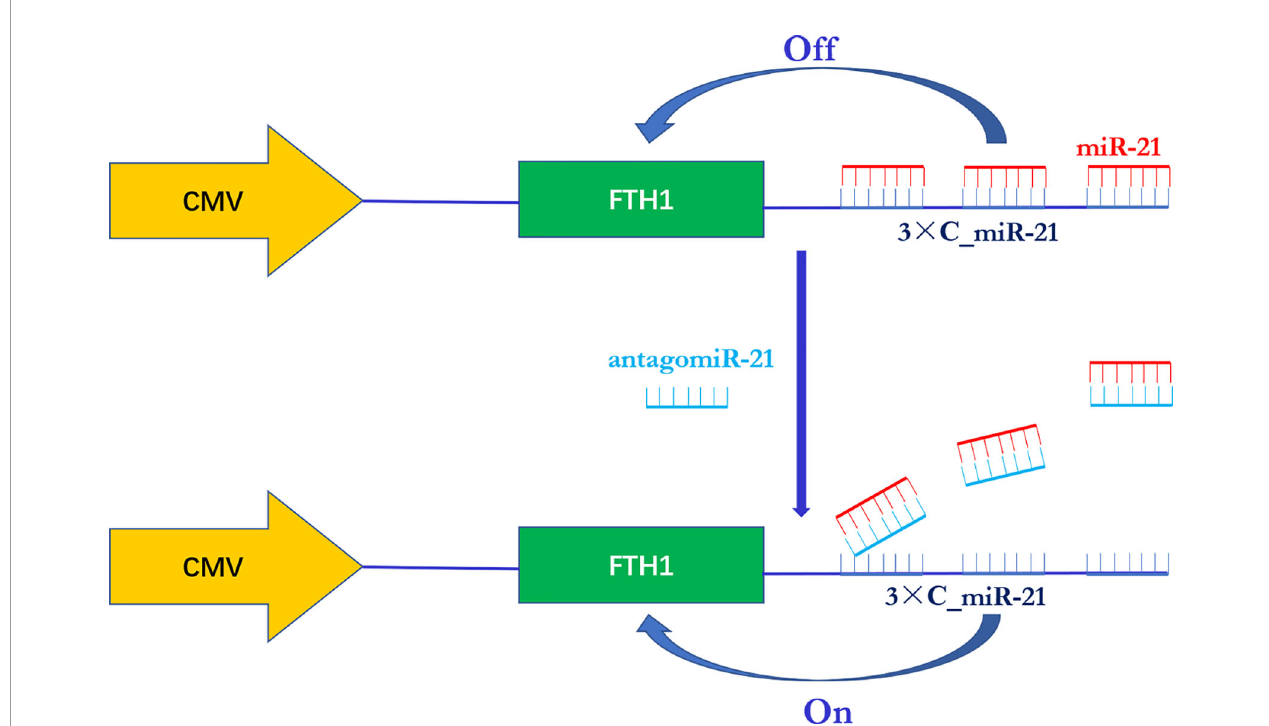
FIGURE 1 | Schematic illustration of the miR-21-responsive FTH1 gene reporter system. The reporter gene FTH1 is modi fi ed by the addition of 3 copies of the sequence completely complementary to miR-21 (3xC_miR-21) to its 3 ’ -untranslated region (3 ’ UTR). In the presence of miR-21, FTH1 expression is switched “ off ” due to the combination of miR-21 with the 3 ’ UTR of the reporter gene. Once an exogenous antisense oligonucleotide (antagomiR-21) is administered, it binds to miR-21 in a competitive manner and releases miR-21 from the 3 ’ UTR of FTH1, thereby switching “ on ” reporter gene